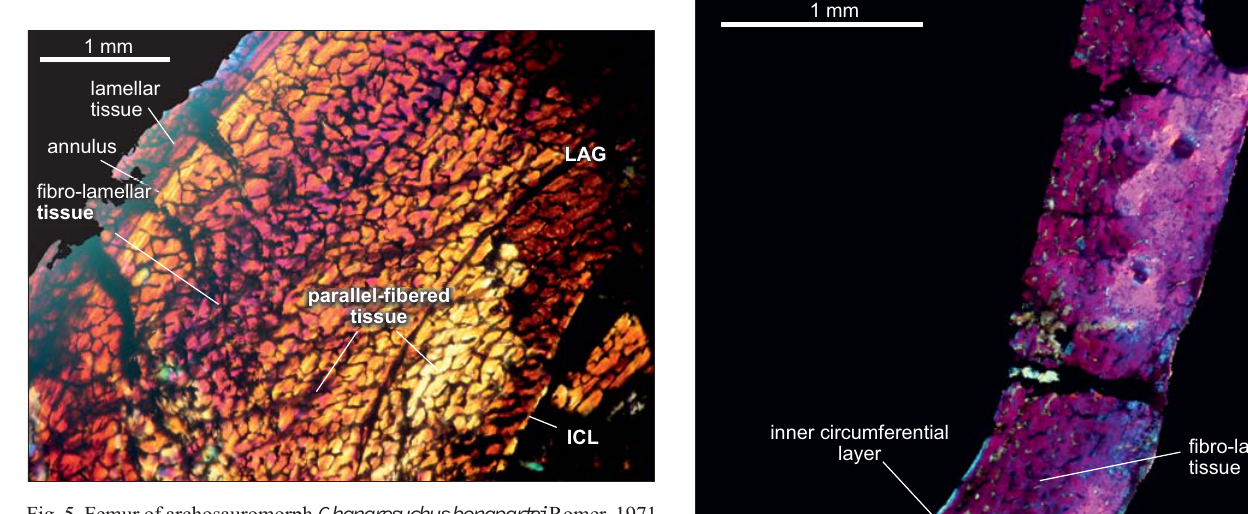
Fig. 4. Tibia of archosauromorph Lagerpeton chanarensis Romer, 1971 (PVL-4625, in lambda light) from La Rioja province, NW Argentina; Chañares Formation, Carnian (Late Triassic). Section showing the main features of the tibia bone microstructure. Abbreviations: ICL, Inner Circum- ferential Layer; LAG, line of arrestred growth.